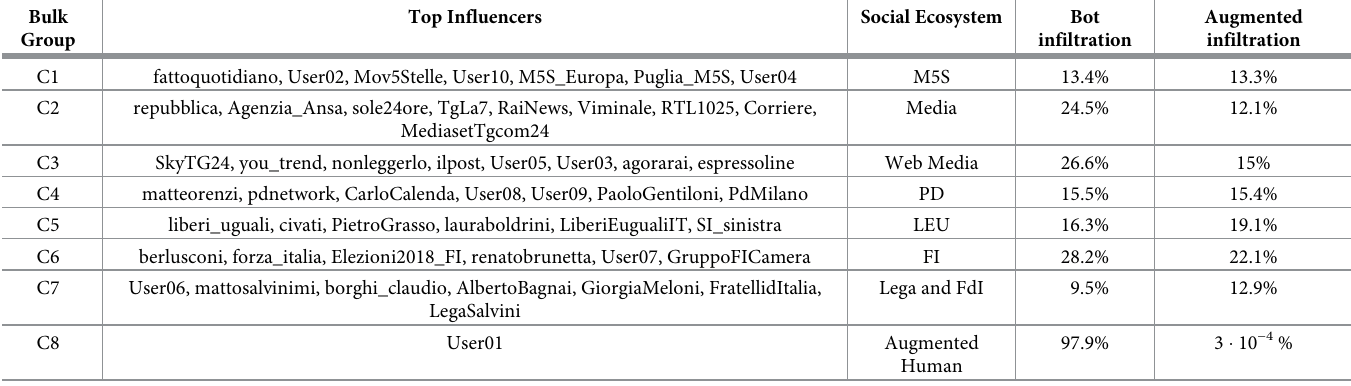
Table 2. Largest online social groups. Most populated communities (with more than 250 users) in the social bulk, with top influencers listed per group. Top influencers are identified as hubs in the bulk network. As evident from the similarities among top influencers, groups reflect specific ecosystems of the Italian voting event: “Movi- mento 5 Stelle” (M5S), traditional media (Media), media with massive online presence (Web Media), “Partito Democratico” (PD), “Liberi e Uguali” (LEU), “Forza Italia” (FI), “Lega” and “Fratelli d’Italia” (Lega and FdI), and then the augmented human with all his/her interacting bots (Augmented Human). Bot (augmented) infiltration indi- cates the percentage of bot users (augmented humans) in each group. Excluding the community corresponding to the augmented human (made for 97.9% of bots), the mean bot infiltration in the bulk network is 29.2% while the mean augmented infiltration is 15.7%. The media groups are richer in bots as expected, since they include news media and online accounts of news papers. Note that users not corresponding to public groups, public entities or individuals with a public political profile (e.g., elected for a specific political party) have been anonymized. Interestingly, the account of User09 has been later suspended by Twitter for violating its policies. Top Influencers Social Ecosystem Bot